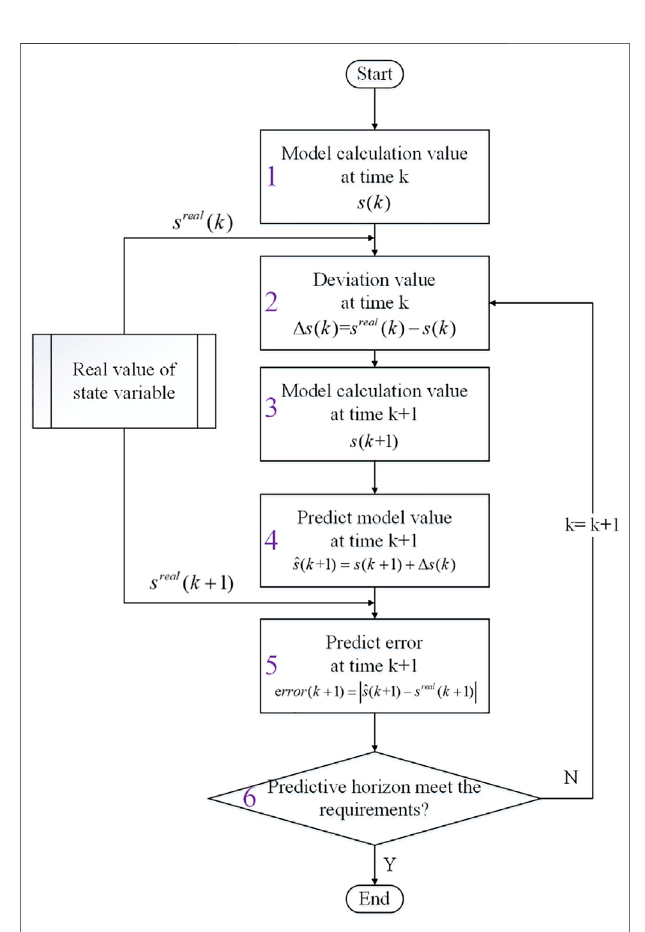
FIGURE 8 | Model prediction fl